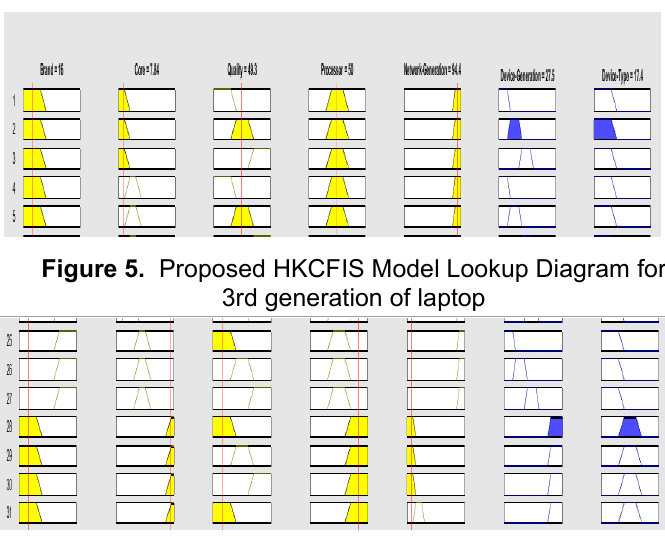
Figure 3. Proposed HKCFIS Model Lookup Diagram for Smart Mobile Phone